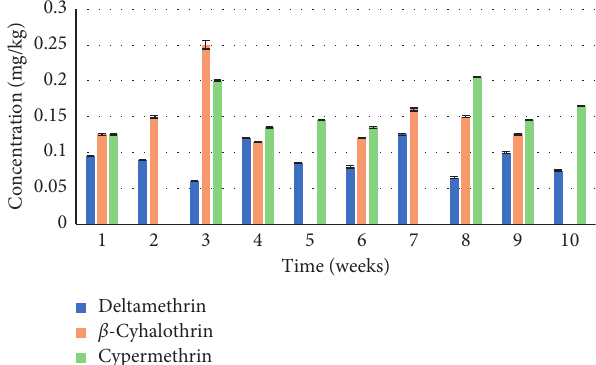
Figure 5: Concentration of pyrethroids in brinjal